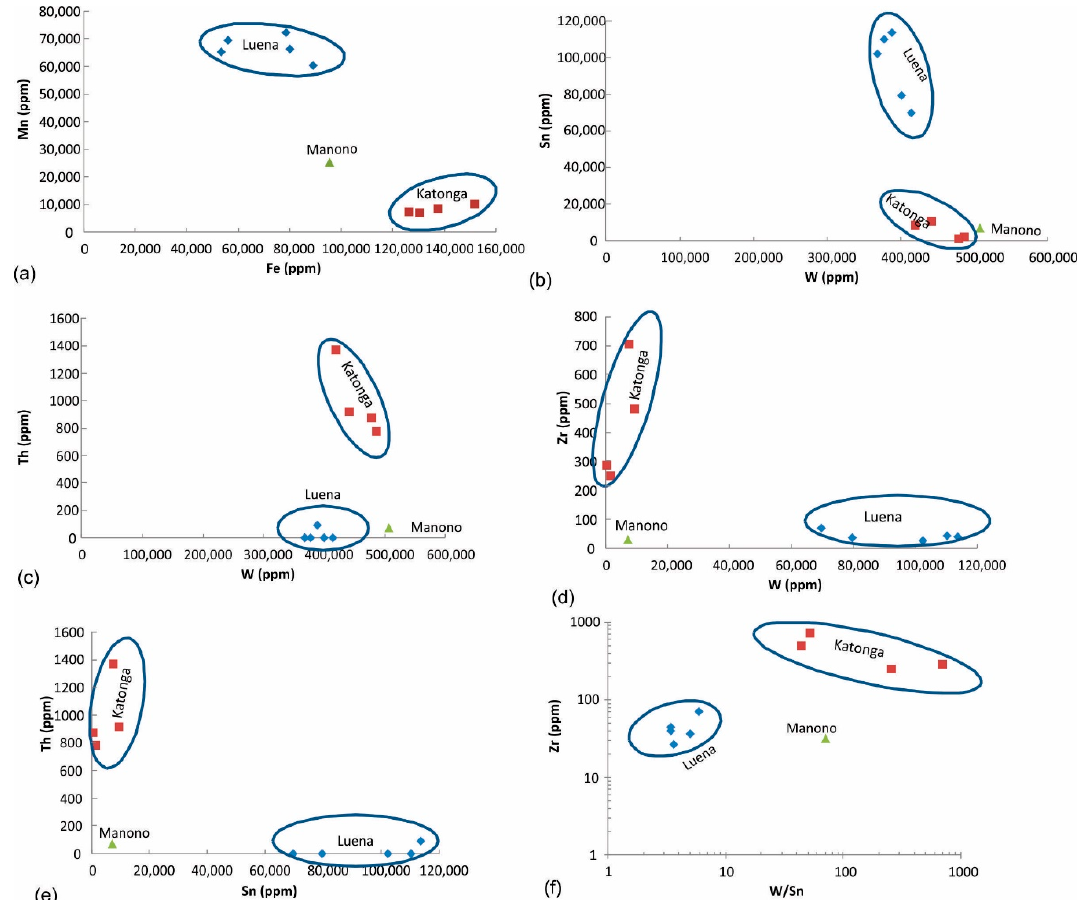
Figure 8. Discrimination of wolframite ore samples based on ( a ) Fe and Mn, ( b – f ) combination of W, Sn, Th, and Zr concentrations.